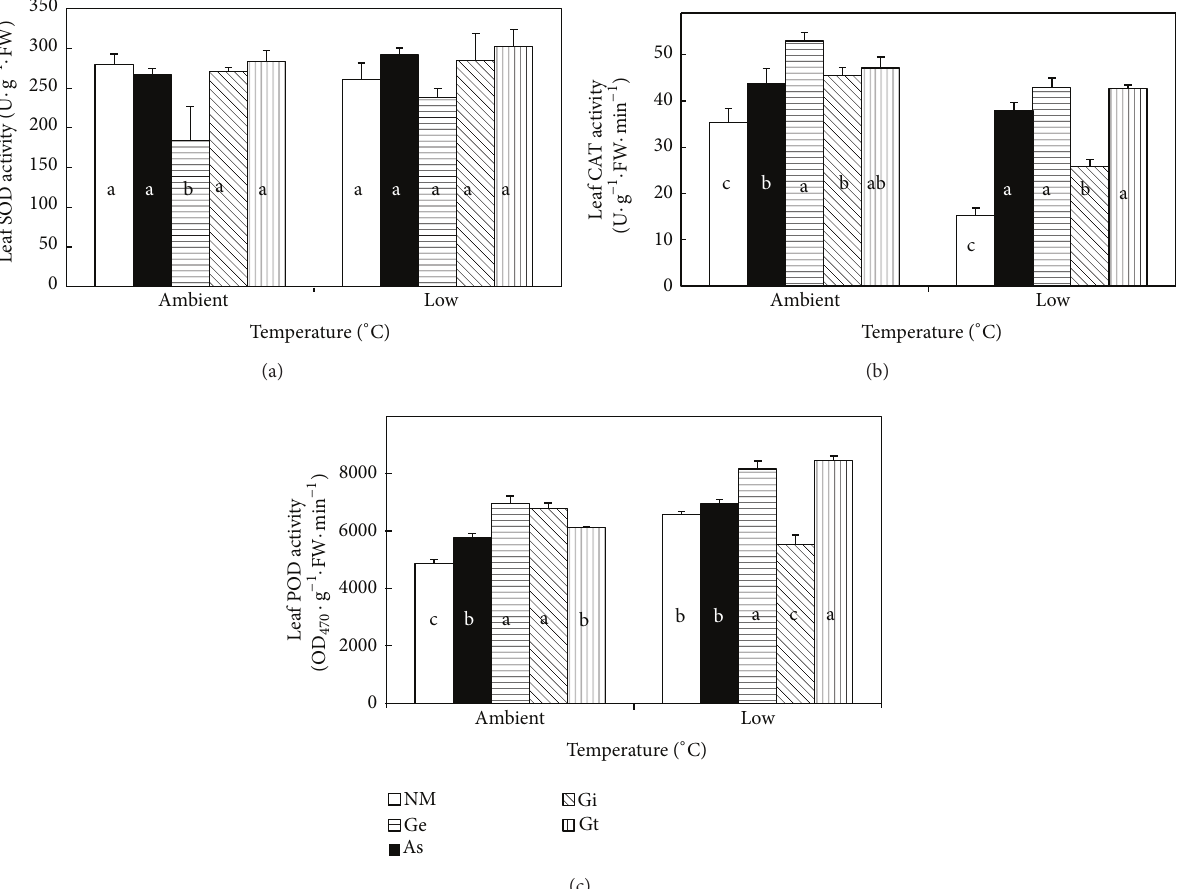
Figure 3: Leaf SOD (a), CAT (b), and POD activities (c) of maize seedlings as influenced by different AMF treatments under ambient temperature and low temperature regimes. NM: non-AM fungus; As: Acaulospora scrobiculata ; Ge: Glomus etunicatum ; Gi: G. intraradices ; Gt: G. tortuosum . Bars represent the mean ± SE of five replicates. For each temperature, mean values ( ± SE) labelled with different letters are significantly different ( 𝑃 < 0.05 ) by Duncan’s